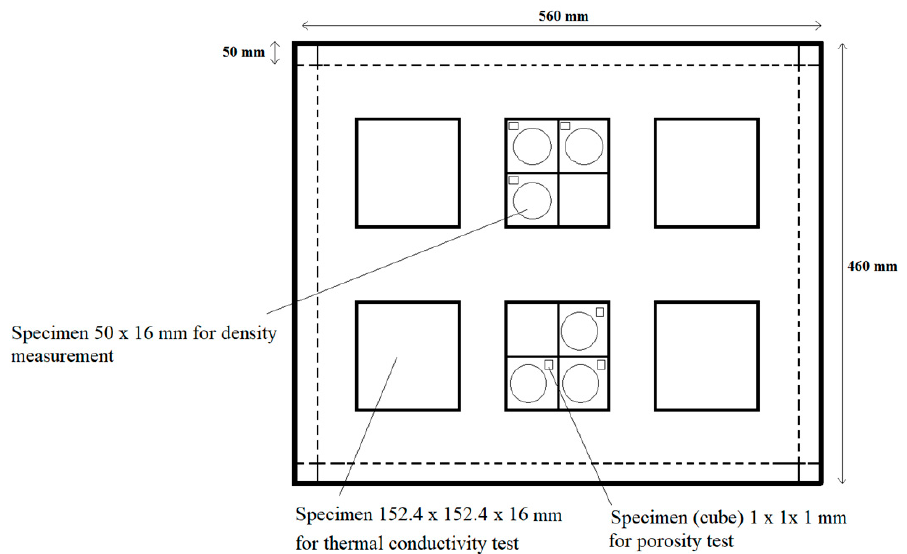
Figure 3. Specimen cutting scheme in each laboratory panel. Fibers 2018 , 6 , x FOR PEER REVIEW